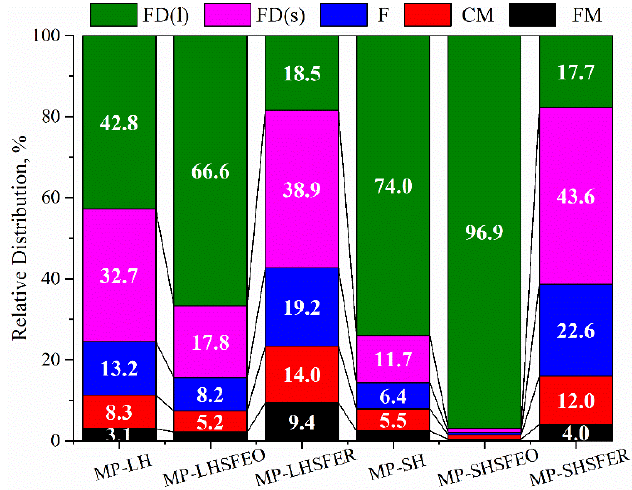
Figure 18. Anisotropic texture distribution of several mesophase pitches.